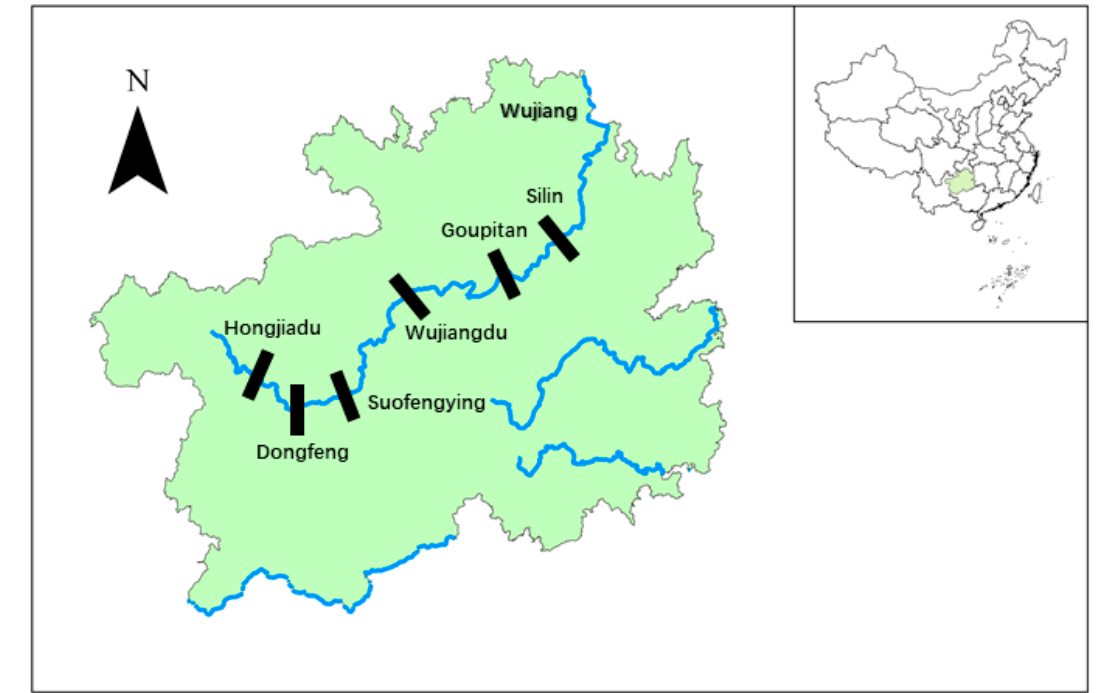
Figure 1. The Location of Each Reservoir of Wujiang Cascaded Hydropower System.